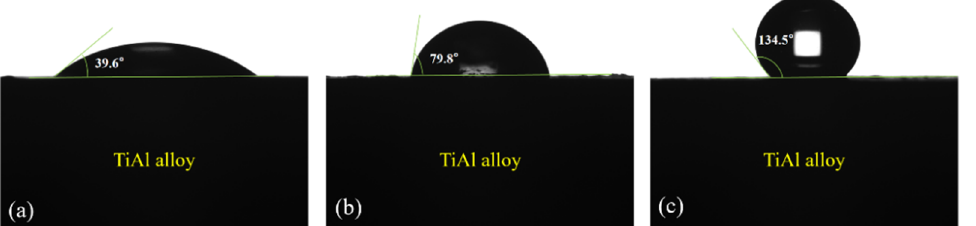
Figure 3. The wettability of the NaF ‐ containing aqueous solution on the γ‐ TiAl alloys: ( a ) pristine γ‐ TiAl alloy, ( b ) fluorine ‐ treated γ‐ TiAl alloy after isothermal oxidation, ( c ) bare TiAl alloy after isothermal oxidation.